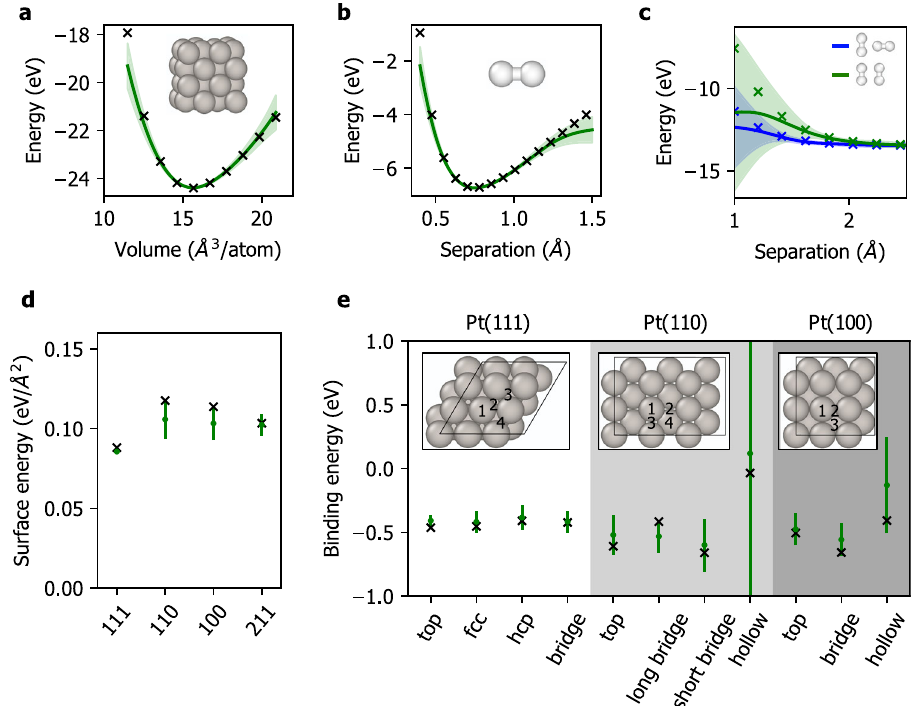
Fig.3|ValidationoftheH/PtSGPforce fi eld. Ineachplot,shadedregionsindicate 99% con fi dence regions of the SGP model. a Energy versus volume of bulk Pt. b Energy versus H – H bond distance of a single H 2 molecule. c Energy versus